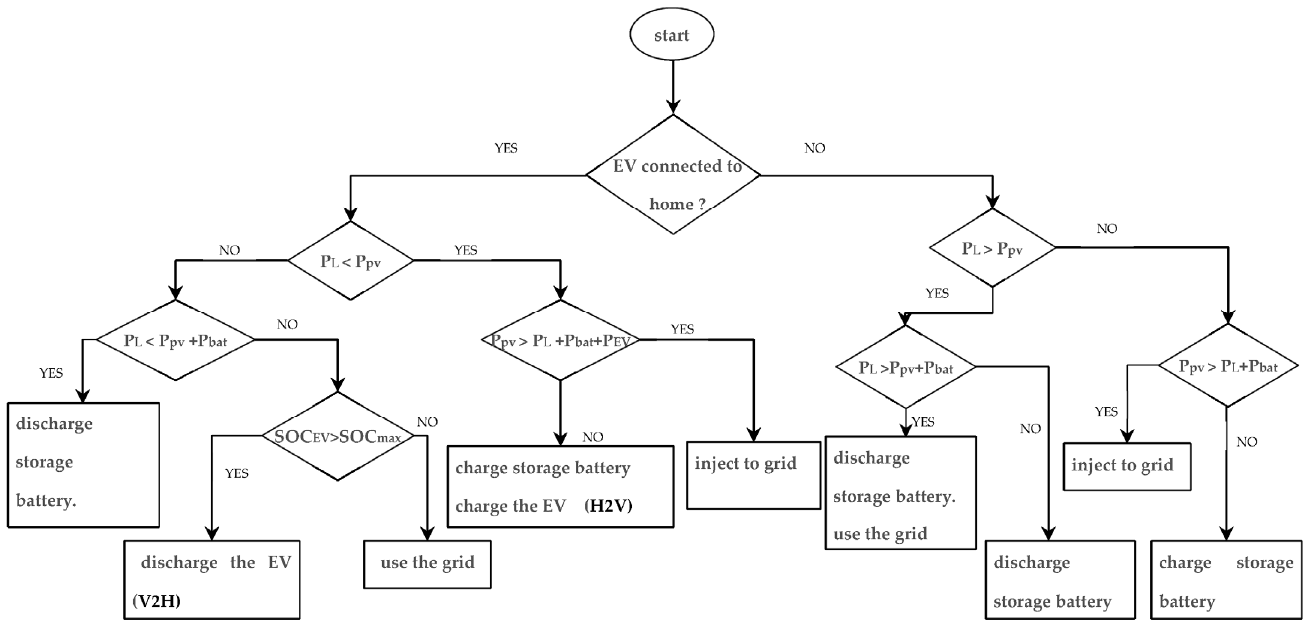
Figure 6. Proposed residential EMS fl